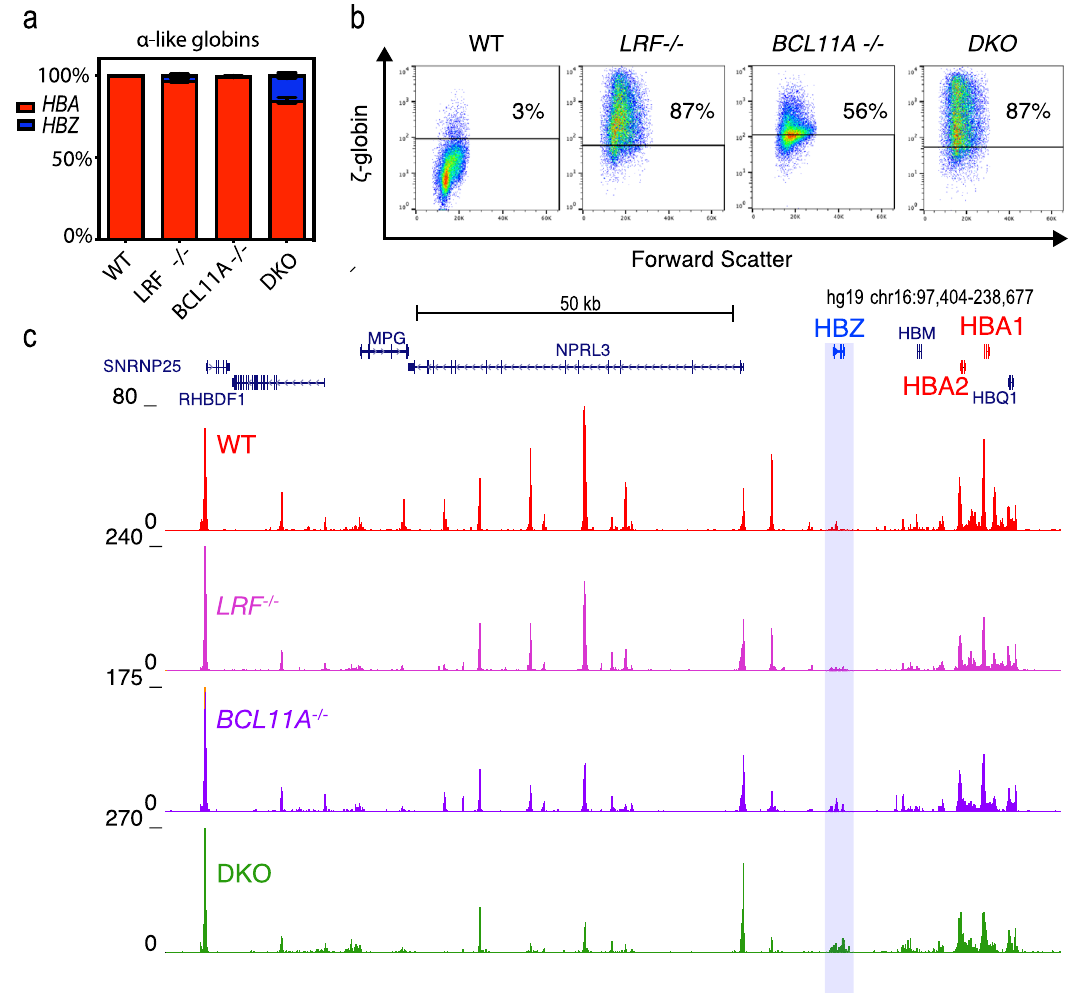
Fig. 7 Role of LRF and BCL11A in humans. a Bargraphs showing the proportion of ζ -globin transcripts ( HBZ ) to adult α -globin at Day 10 of differentiation (bars show the mean ± SD); N = 3 biologically independent samples). b Flow cytometry for the ζ -globin chain at Day 10 of differentiation. The proportion of ζ -globin positive cells are shown. The negative line was set using an isotype control for each cell line. c ATAC-seq at Day 10 of differentiation on 10,000 cells. The ζ -globin ( HBZ ) gene is indicated by the blue bar. Source data are provided as a Source Data fi